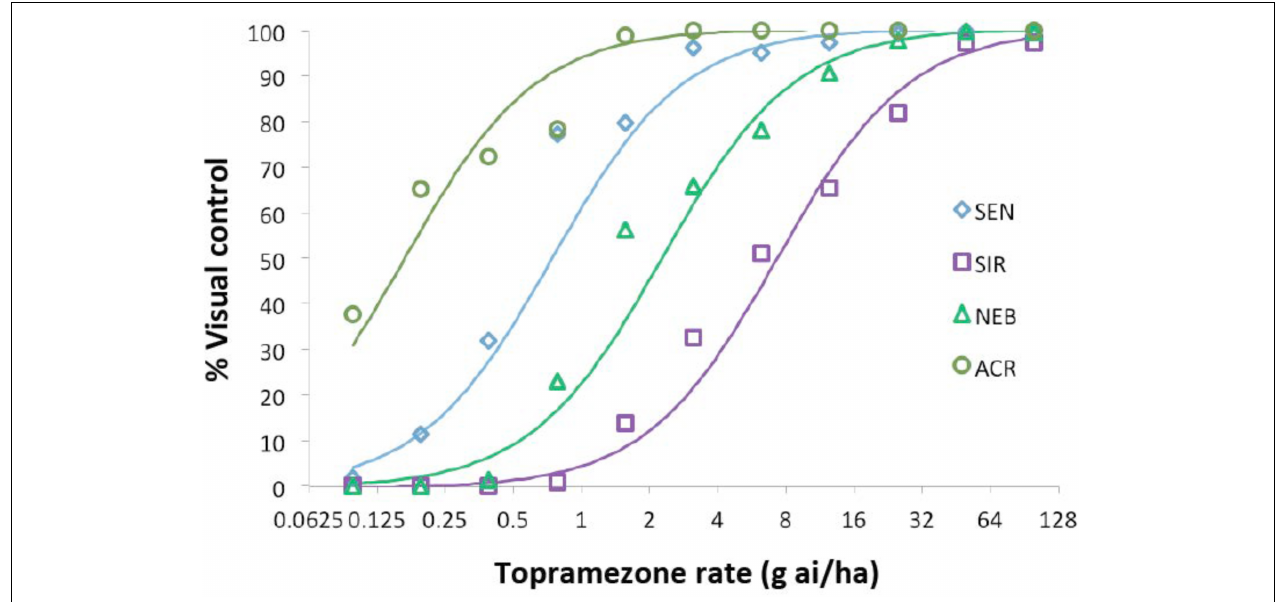
FIGURE 2 | Dose-response analysis of topramezone in four waterhemp populations in the greenhouse. Waterhemp plants (7-cm) from each population were treated with various rates of topramezone, including Agridex at 1% (v/v) (Helena Chemical) and ammonium sulfate at 2.5% (w/v) as spray adjuvants. Plants were assessed for visual percent control compared to an untreated control for each corresponding population at 21 days after treatment. Dose-response curves were generated as described in Section “Materials and Methods” and used to determine the 50% growth reduction and resistance index values listed in Table 1 . SIR and NEB are HPPD inhibitor-resistant populations while ACR and SEN are sensitive to HPPD inhibitors (O’Brien et al., 2018).